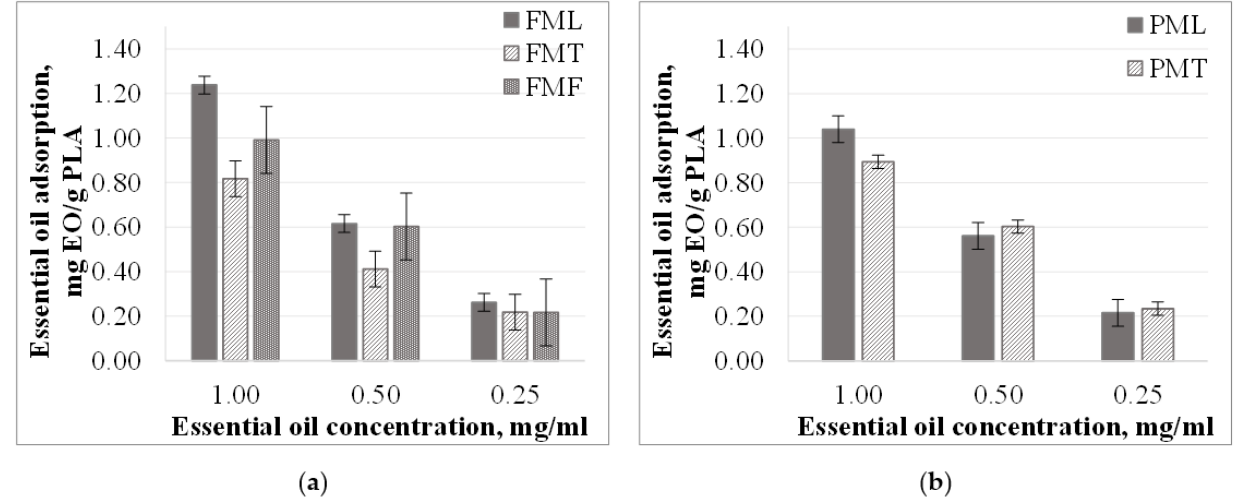
Figure 4. Essential oil adsorption (mg EO /g PLA ) in methanol solutions in the case of ( a ) particles from F granules; ( b ) particles from P granules.